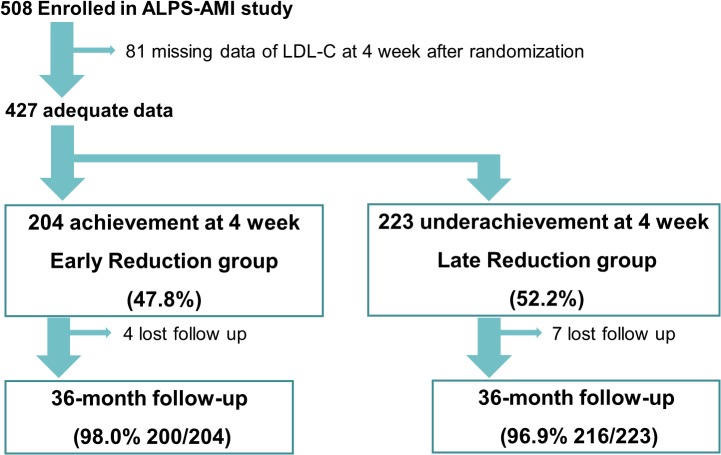
Study flowchart.